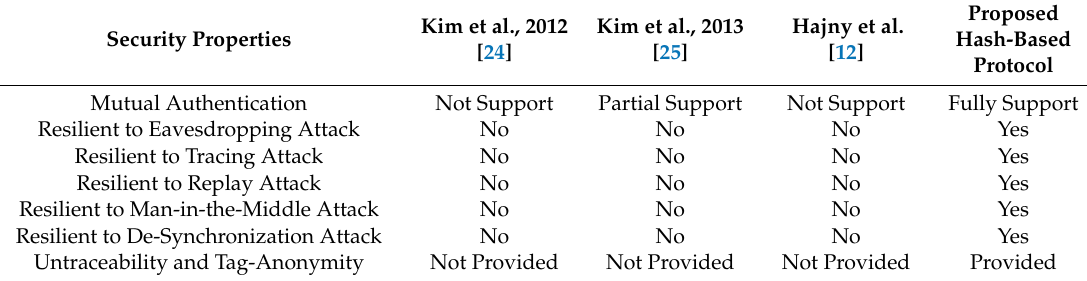
Table 3. Security properties of various hash-based RFID protocols.